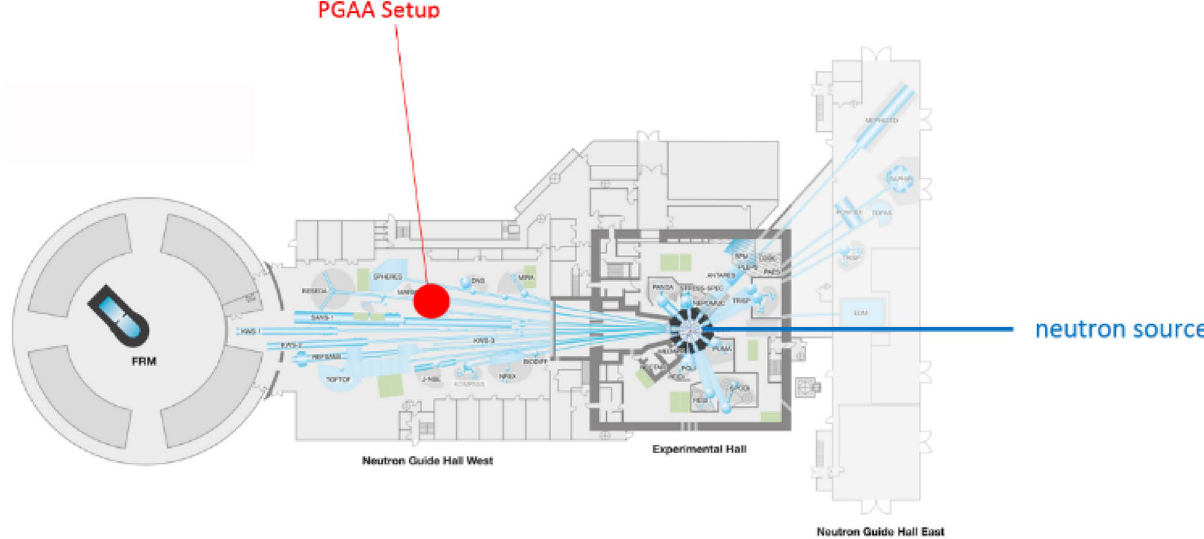
Figure 7. Reactor assessment FRM II, schematic overview. mod. n. MLZ Overview: Lageplan_2013_All_engl; http:// www. mlz- garch ing. de/ instr umente/ bildg ebende- verfa hren- und- analy se. html. Accessed 01 October